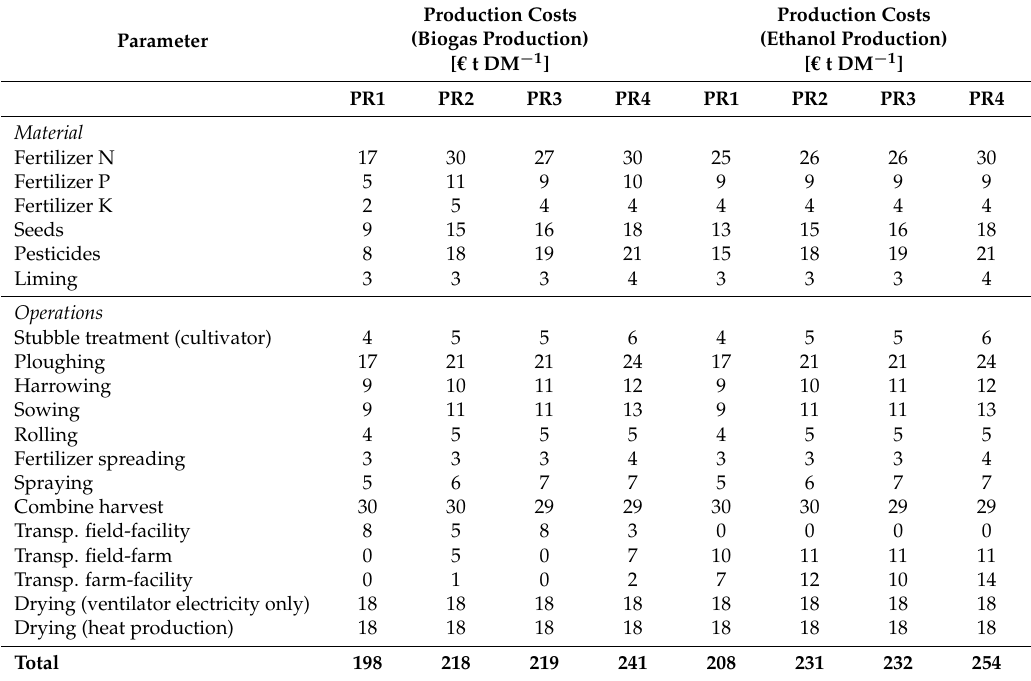
Table A11. Feedstock production costs [ € t DM − 1 ] for winter wheat grains in the different production regions (PR) for the production of biogas and